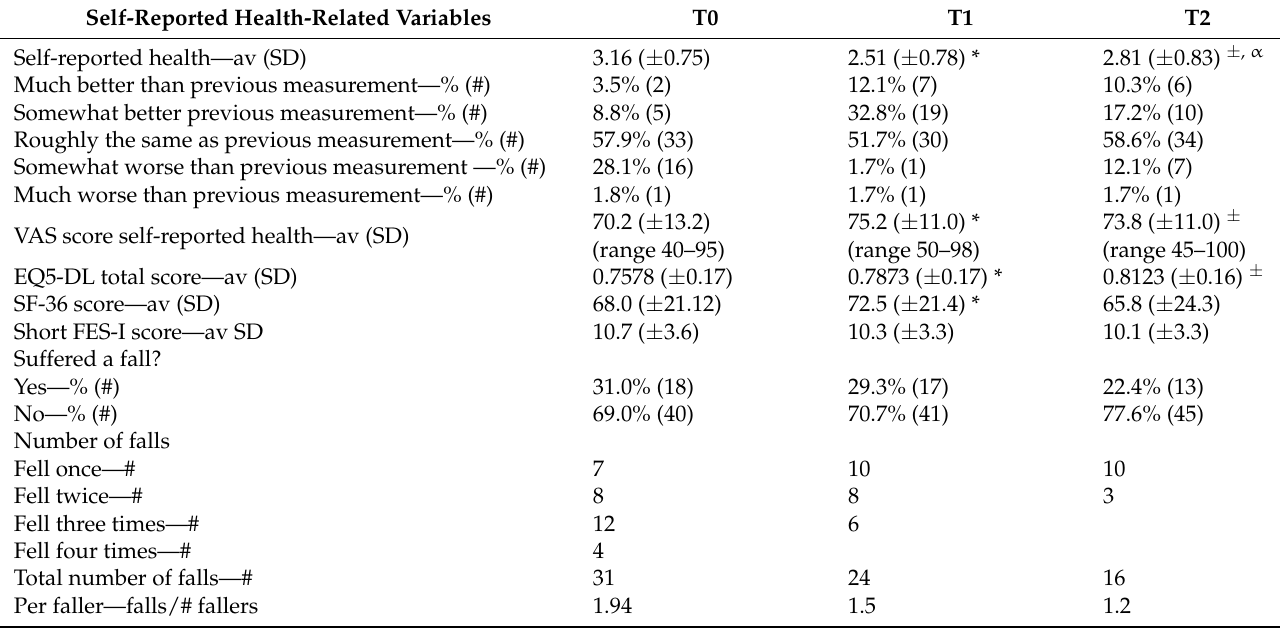
Table 1. Scores on health-related measurements on T0, T1 and